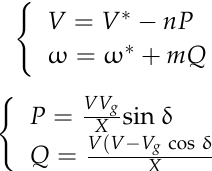
Figure 22. Steady-state power of Case III: ( a ) active power, and ( b ) reactive power.